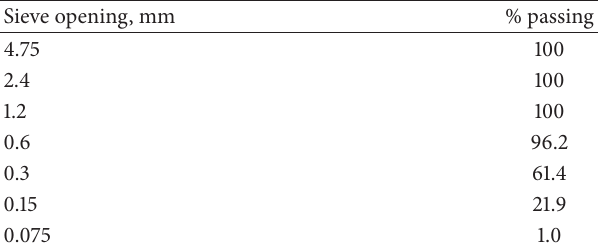
Table 2: Dune sand